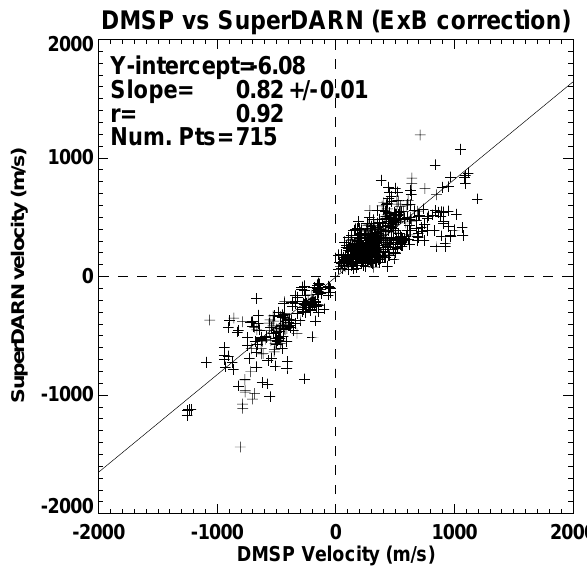
Fig. 14. Same as in Fig. 13 but corrected for E/B 0 ratio change with altitude.